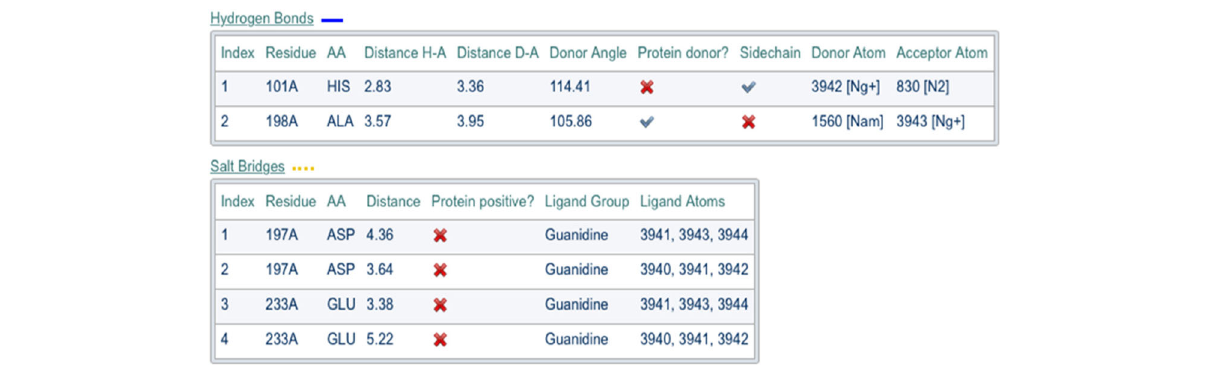
Table 16 Hydrogen bonding and hydrophobic interactions between quercetin and amino acid residues within α -amylase binding site